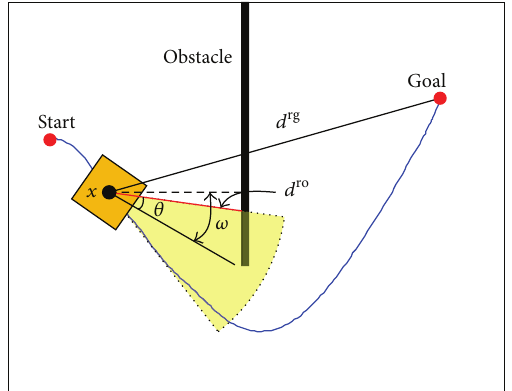
Figure 3: Useful data collected by sensors. Line in blue shows the demonstrated trajectory. Sectors with a fan shape in shallow yellow color represent the visual field of the Kinect. {𝑥, 𝜔,𝑑 ro , 𝑑 rg } represent location, orientation, and distance information of the robot,